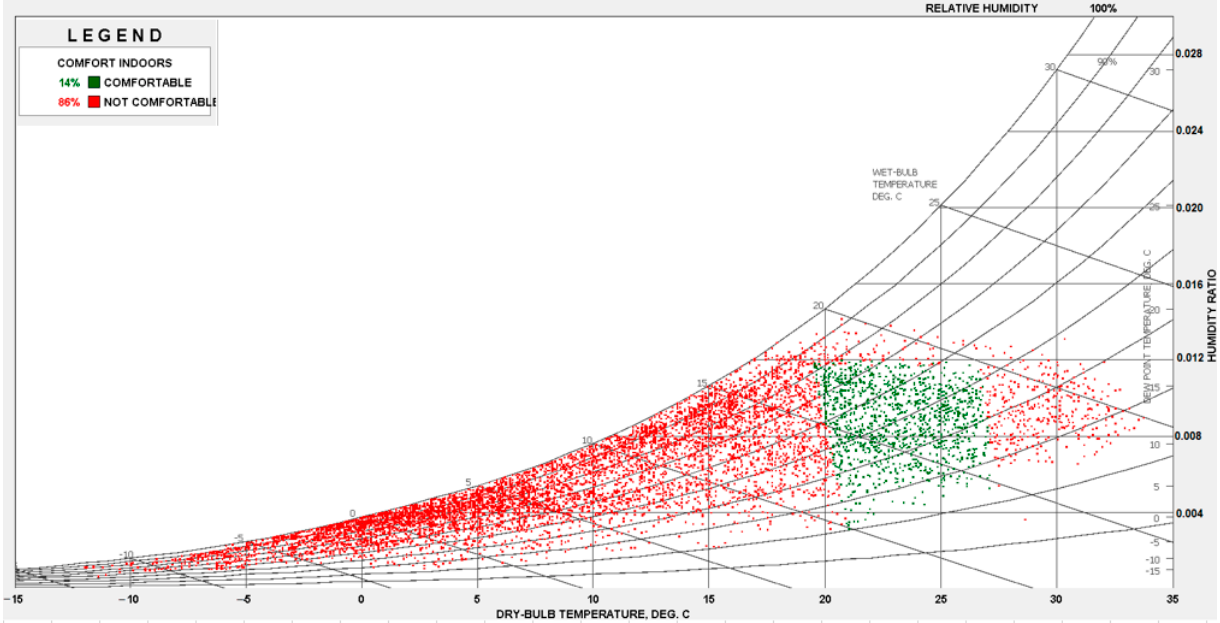
Figure 4. Psychrometric chart for Timi ș oara location (IWEC Data, 152,470 WMO Station): comfort indoors without design strategies. Reprinted from [22].